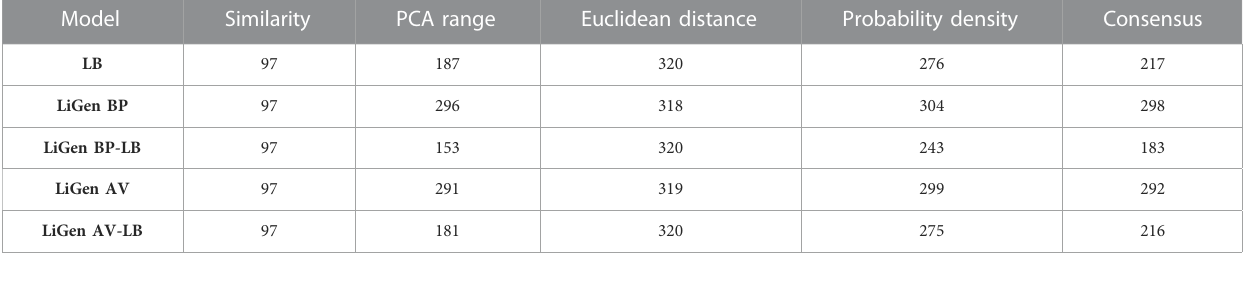
TABLE 5 Number of compounds of the external validation set inside the applicability domain according to each strategy and the consensus approach. Model